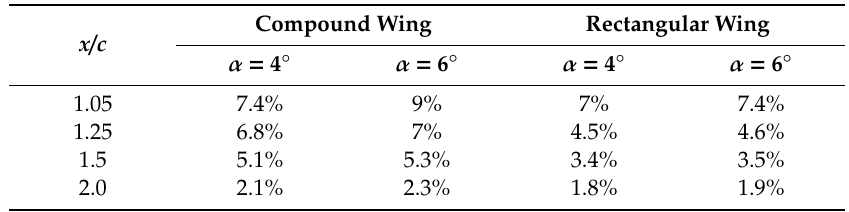
Table 4. The maximum turbulent intensity in the wake region in the back of the compound wing and the rectangular